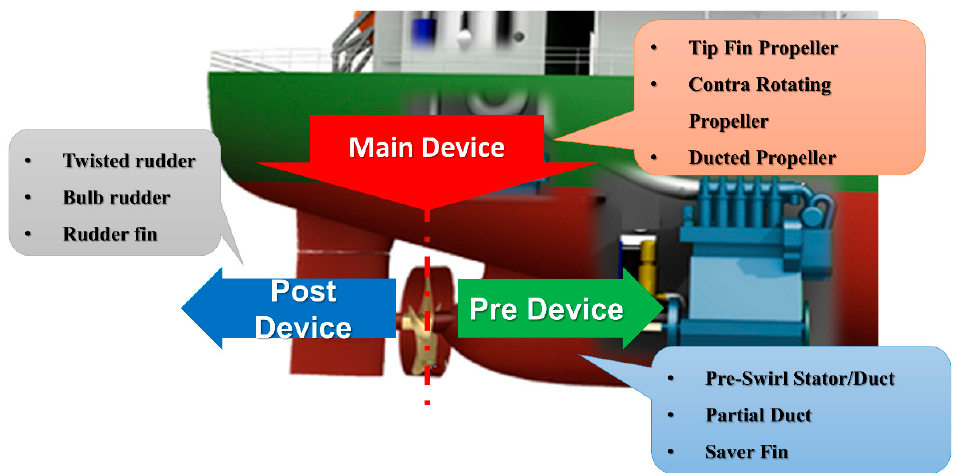
Figure 3. Recently developed ESDs at each zone.